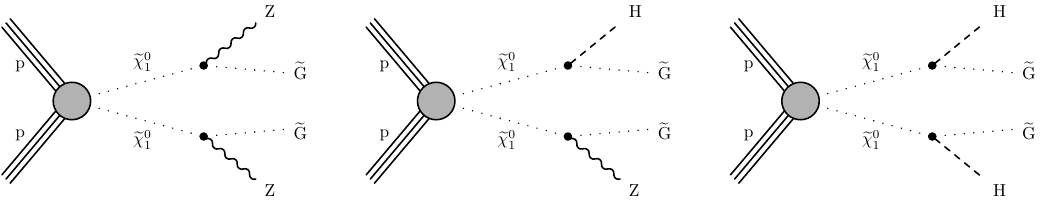
Figure 3 . A GMSB model with higgsino pair production.